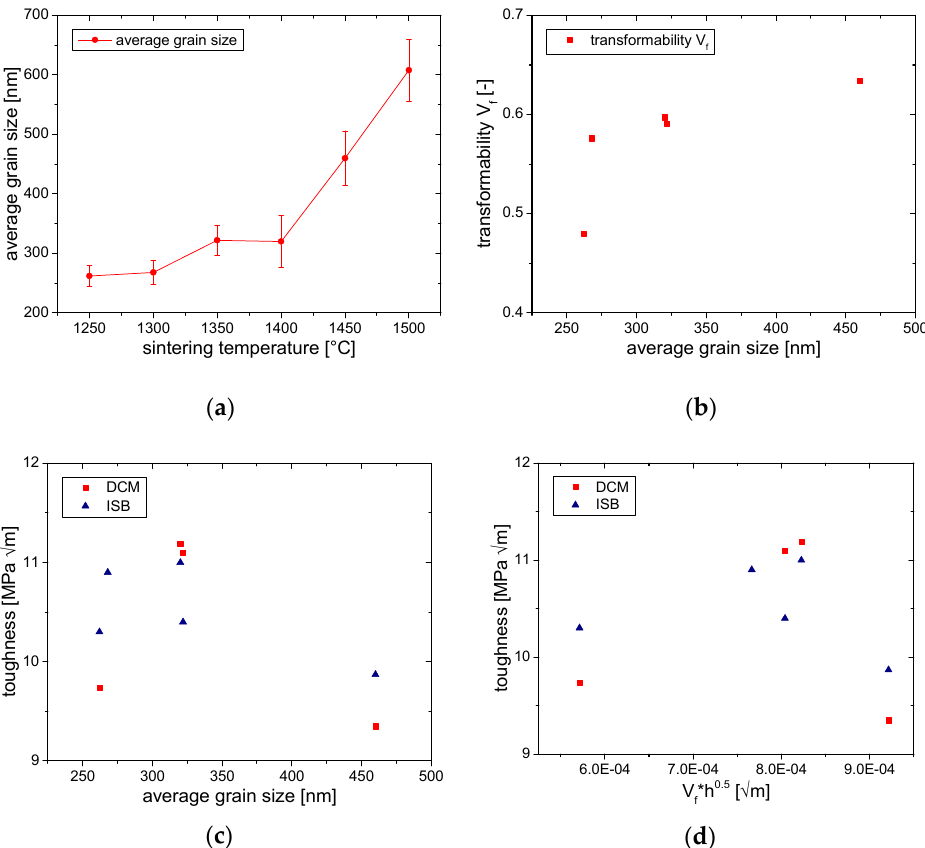
Figure 11. Some correlations between measured and calculated parameters: ( a ) grain size vs. sintering temperature, ( b ) transformability V f vs. grain size, ( c ) toughness vs. grain size, and ( d ) toughness vs. V f ∙√ h.